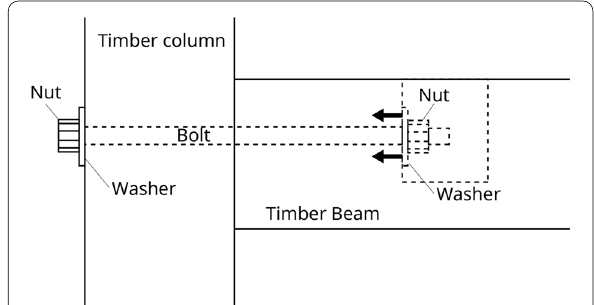
Fig. 1 Tensile bolt connection with partial compressive resistance